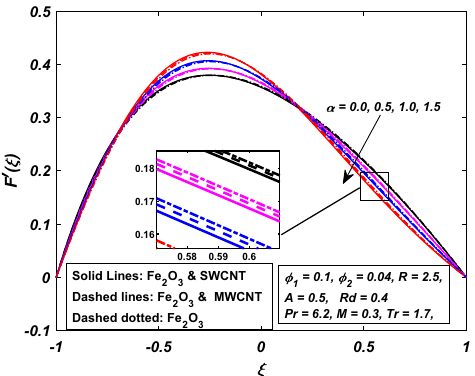
Figure 2. Influence of α on F ′ (ξ) .